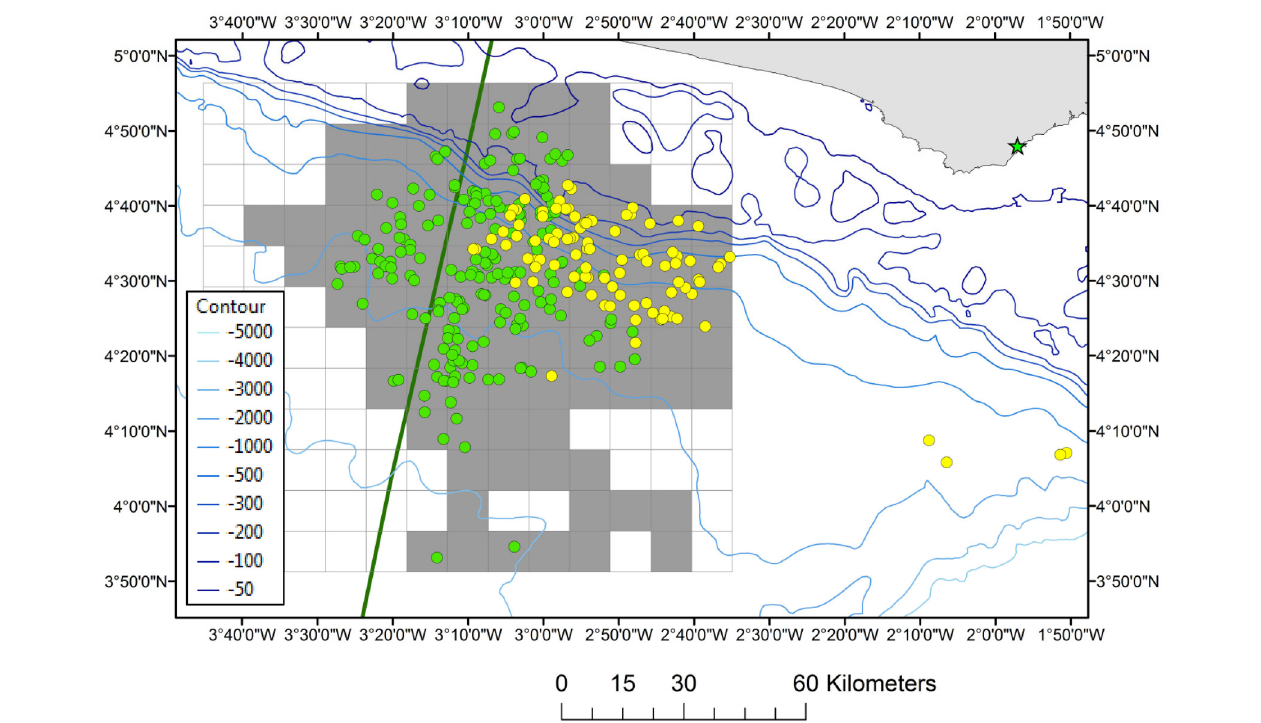
FIGURE 1 | The location of the study area. Grid cells are shaded gray where survey effort (2013 + 2014) took place in the (gridded) survey area. The positions of cetaceans observed in both survey years are depicted as yellow dots (2013) and green dots (2014). The EEZ border between Côte d’Ivoire and Ghana is also shown (green thick line). The position of Dixcove fishing port is presented by a green asterix. Depth contours are displayed from 50 to 5000m water depth.